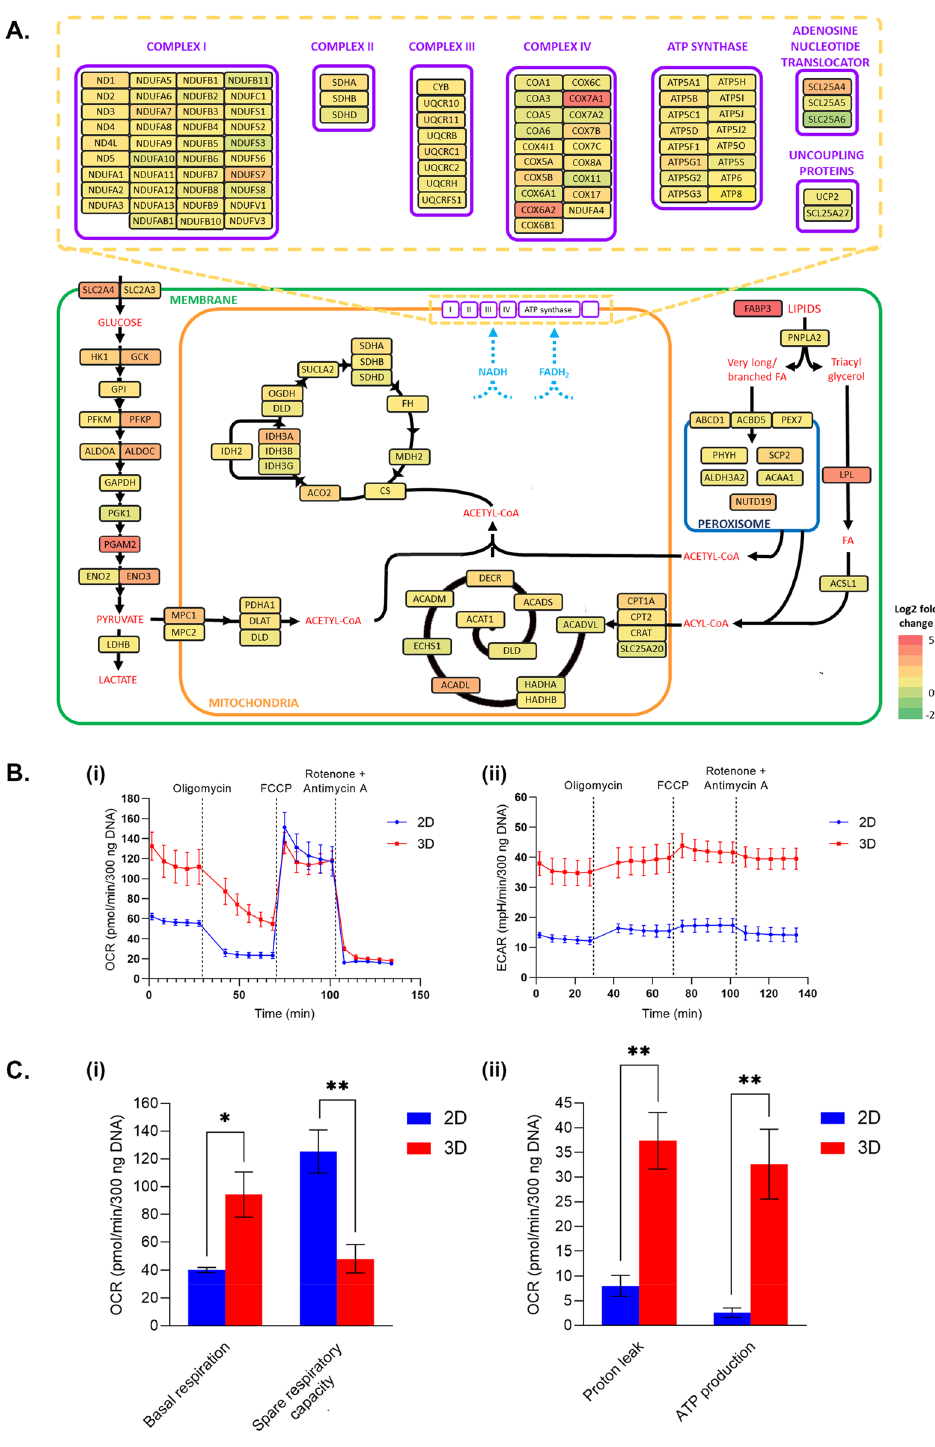
Figure 7. 3D long-term cultures promote changes in metabolic activity towards maturation. ( A ) Diagram showing metabolic genes with significantly upregulated (in red) and downregulated (in green) genes between long-term 3D hOCMTs vs 2D monolayer cultures (log2fold change; p.adj < 0.05). ( B ) Graphs for comparing the cellular energy metabolism of long-term 3D hOCMTs vs 2D monolayer cultures after day 50 using Seahorse XFp Analyzer and Seahorse Mito Stress Test Kit: (i) oxidative phosphorylation (oxygen consumption rate, OCR) and (ii) glycolytic flux (extracellular acidification rate, ECAR) (Mean ± SEM obtained in four independent analyses. Total sample size: n 2D = 12, n 3D = 9). ( C ) Bar graphs providing a detailed analysis of the oxygen consumption rate (OCR) Seahorse XFp Analyzer data presented in ( B ): (i) basal respiration and spare respiratory capacity, (ii) proton leak, ATP production (Mean ± SEM, N = 4, n 2D = 12, n 3D = 9, unpaired Student’s t